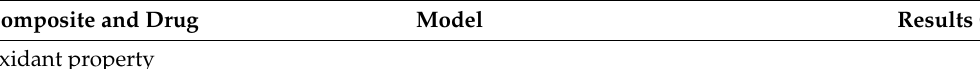
Table 2. Theranostic properties of MSNs in various diseases. All the studies are in the preclinical stage. The information on regulatory approval and clinical trials needs to be